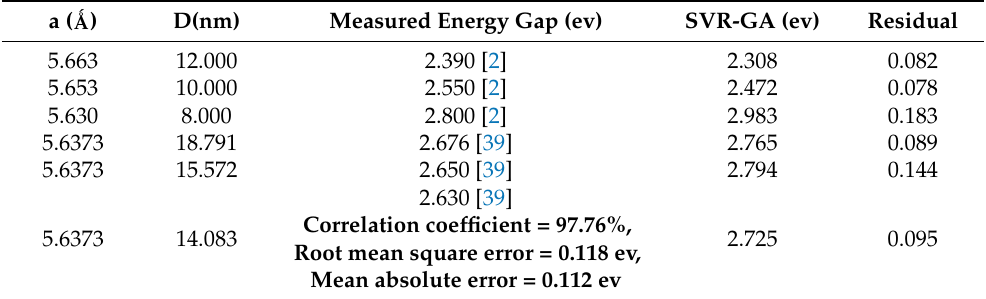
Table 4. Results of further validation of the developed model. Table 1. Description of statistical analysis